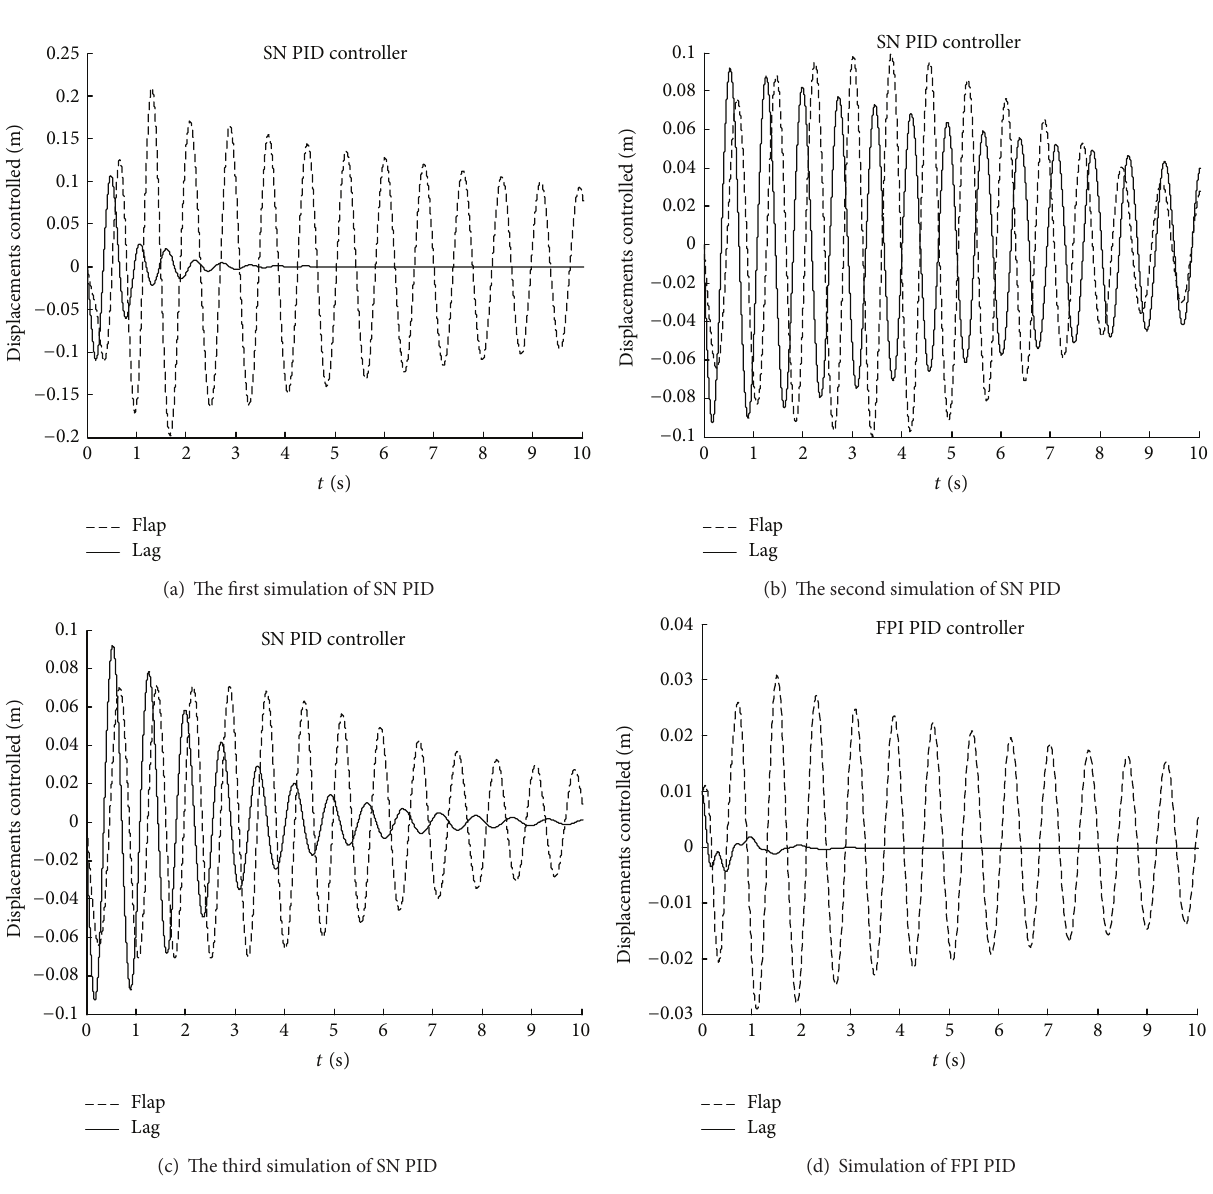
Figure 13: Flap and lag displacements of SN PID control (a)–(c) and FPI PID control (d) for 𝑈 = 30 ms −1 and Ω = 60 rpm.